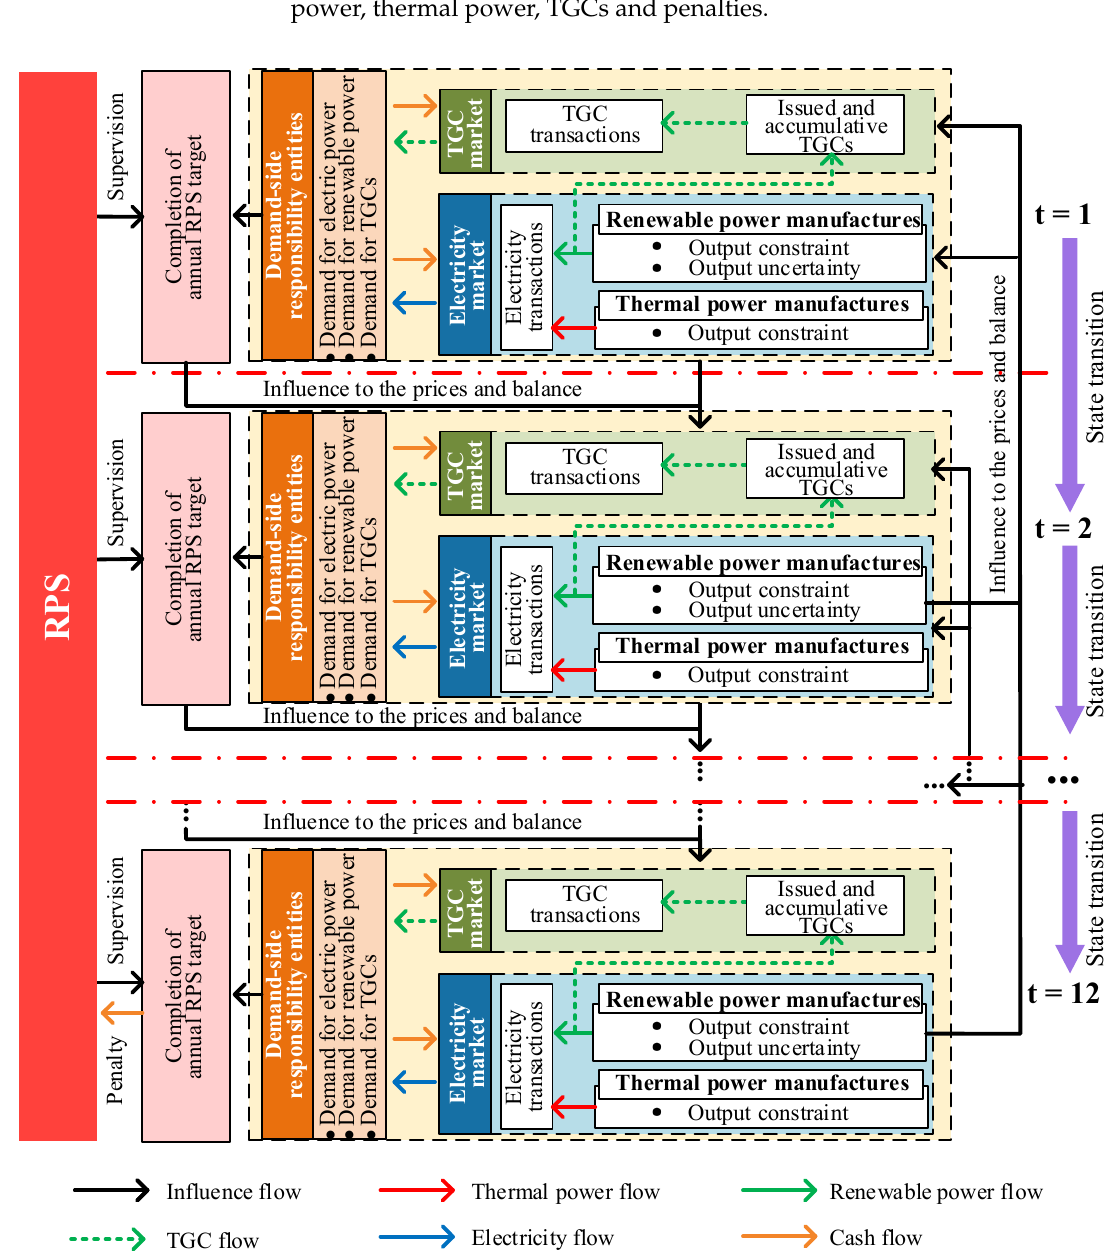
Figure 3. Responsible subjects’ decision-making process.